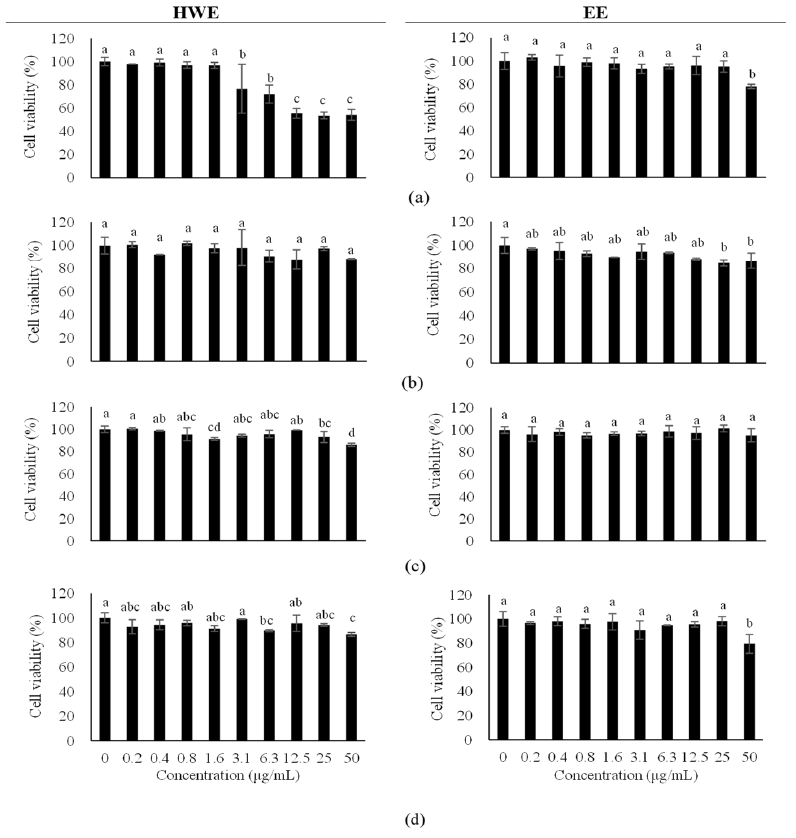
Figure 4. Cell viability of kidney LLC-PK1 cells. Cytotoxicity tests of fermented medicinal plants from HWE and EE. The same letters have no significant differences. ( a ) TM; ( b ) GM; ( c ) GW; ( d ) OM. Cell viability after treatment with TM from HWE decreased from 3.1 μ g/mL with